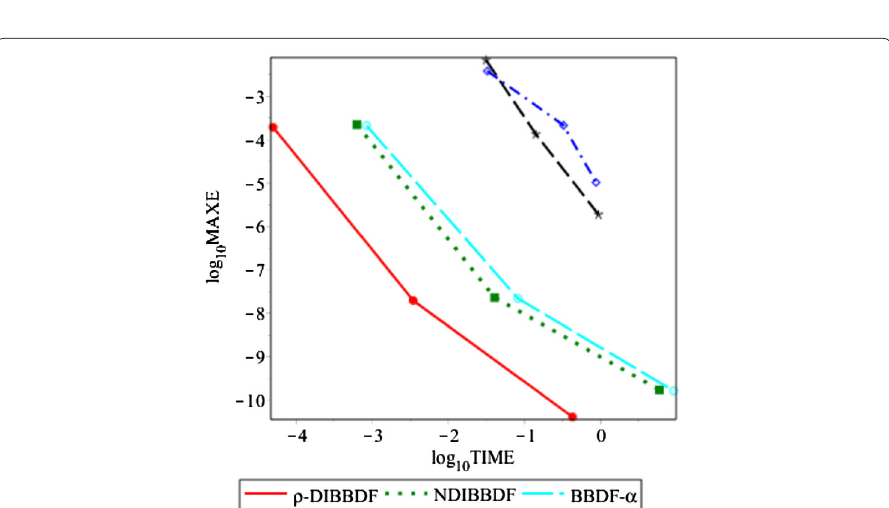
Figure 9 Graph for log 10 MAXE against log 10 TIME of Model B(iii)